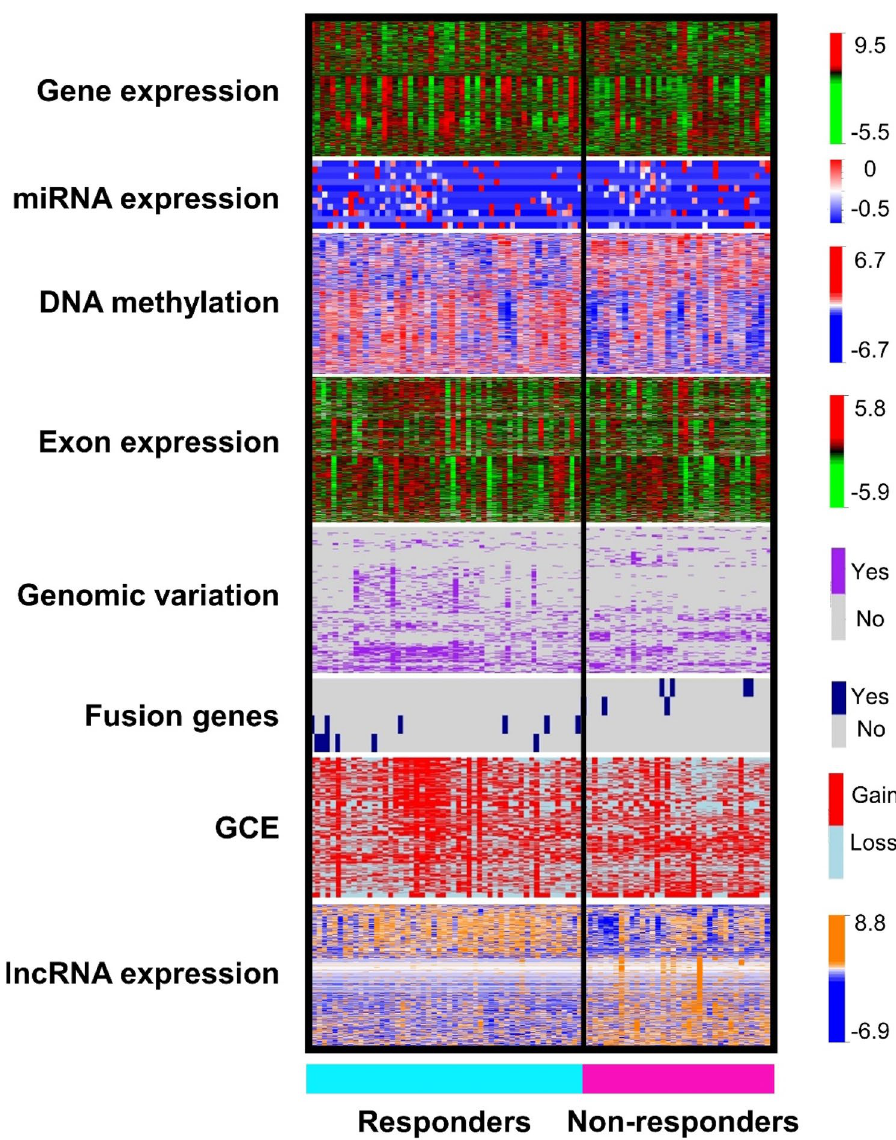
Figure 2. Heatmap of selected variables after univariate ANOVA analysis. Representation of the significant variables after univariate analysis (p < 0.05) for different types of genomic data: gene, miRNA, exon, and long non-coding RNA (lncRNA) expression, DNA methylation, genomic variation, fusion-gene presence, and gene copy estimation (GCE). At the right side of each heatmap there are color-coded range of values for all genomic variables. Heatmaps were generated with R package Heatplus 68 (R version 3.6.3. http://www.r-proje